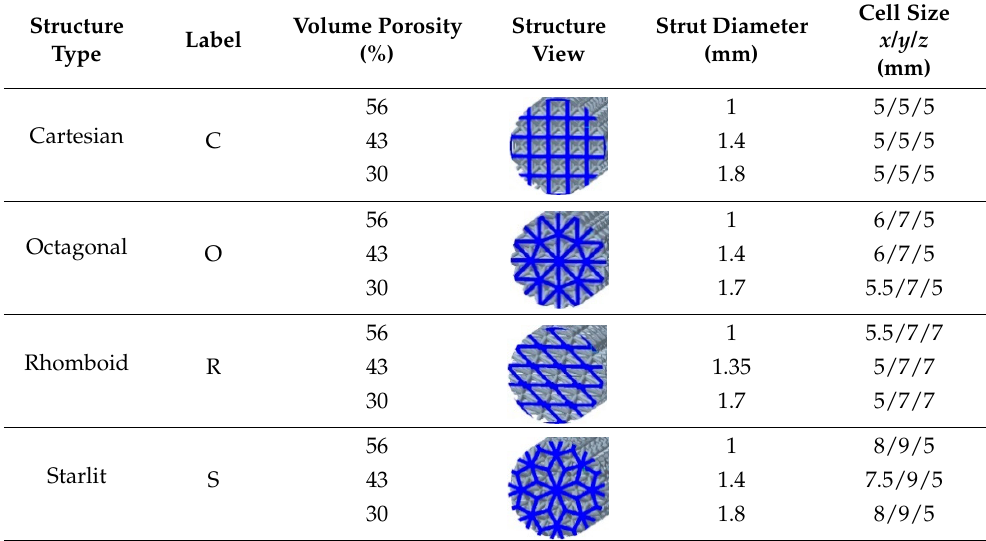
Table 1. Basic characteristics of lattice structures designed to investigate the sound reflection properties.